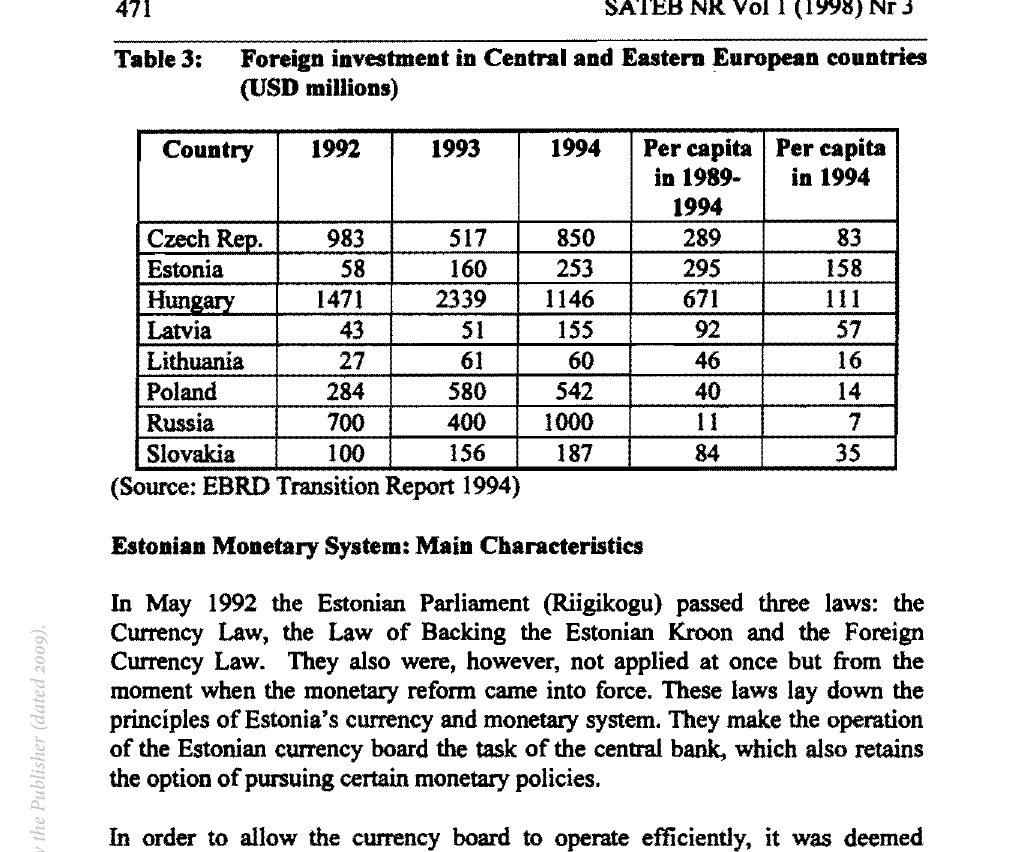
Table 3: Foreign investment in Central and Eastern European (USD millions)